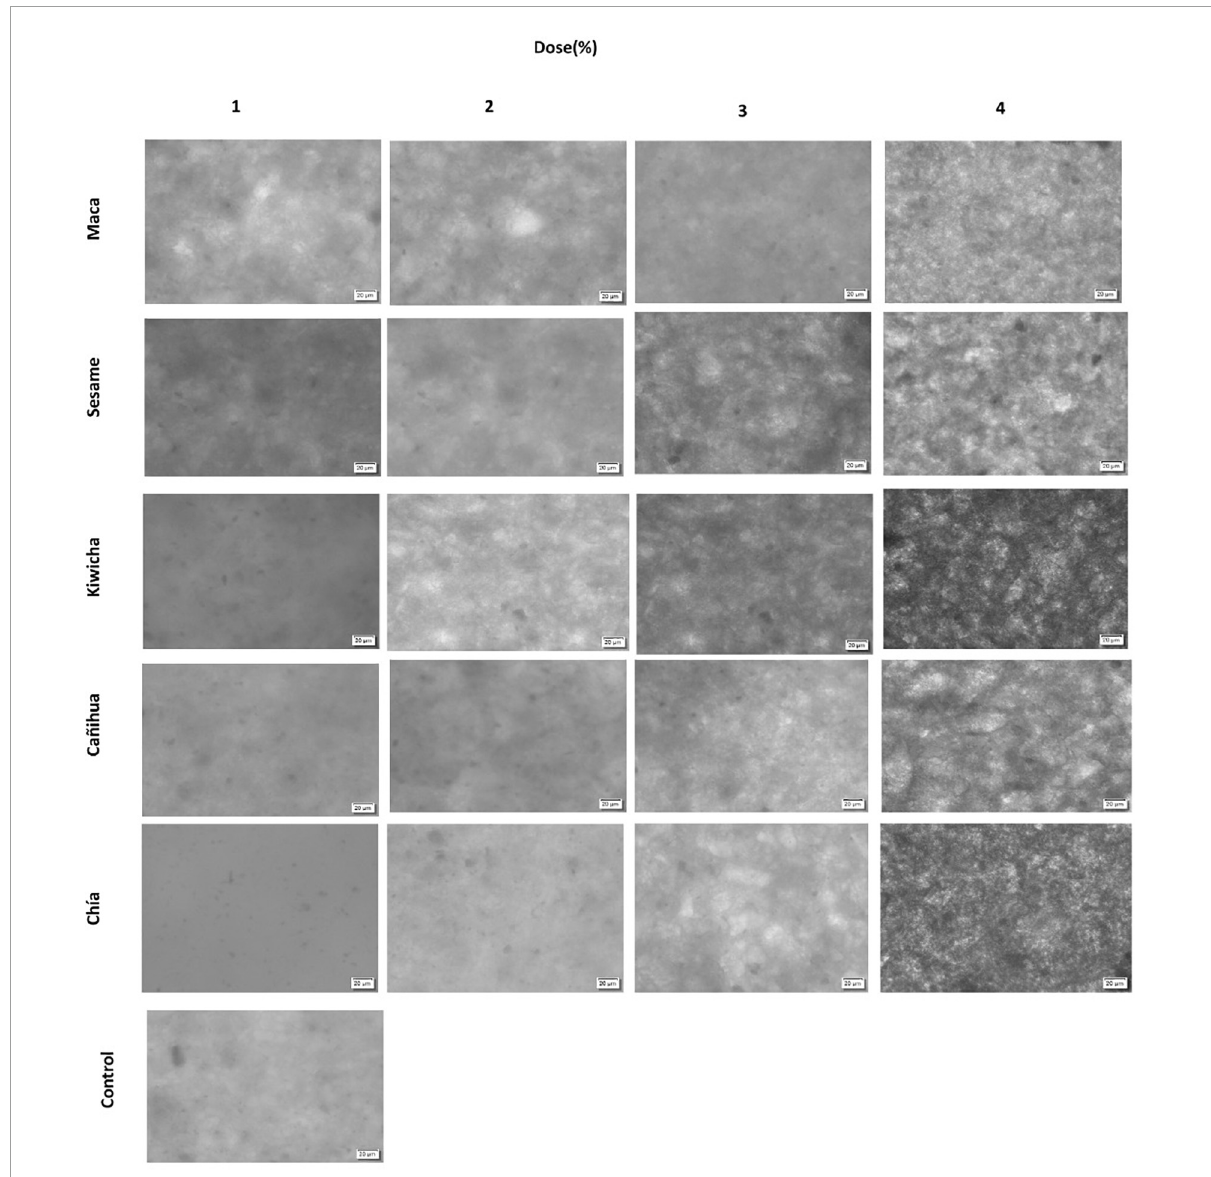
FIGURE2 Micrograph of dark chocolates enriched with high-nutritional value flours in different